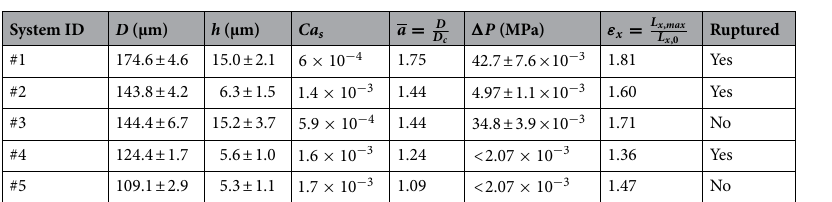
Table 2. Maximum extra pressure-drop and state of the capsule after passing through the constriction for each system